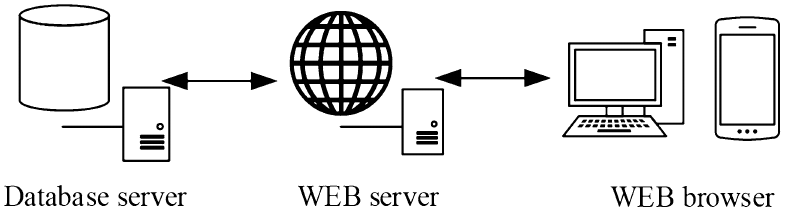
Fig. 8 Schematic diagram of B/S architecture